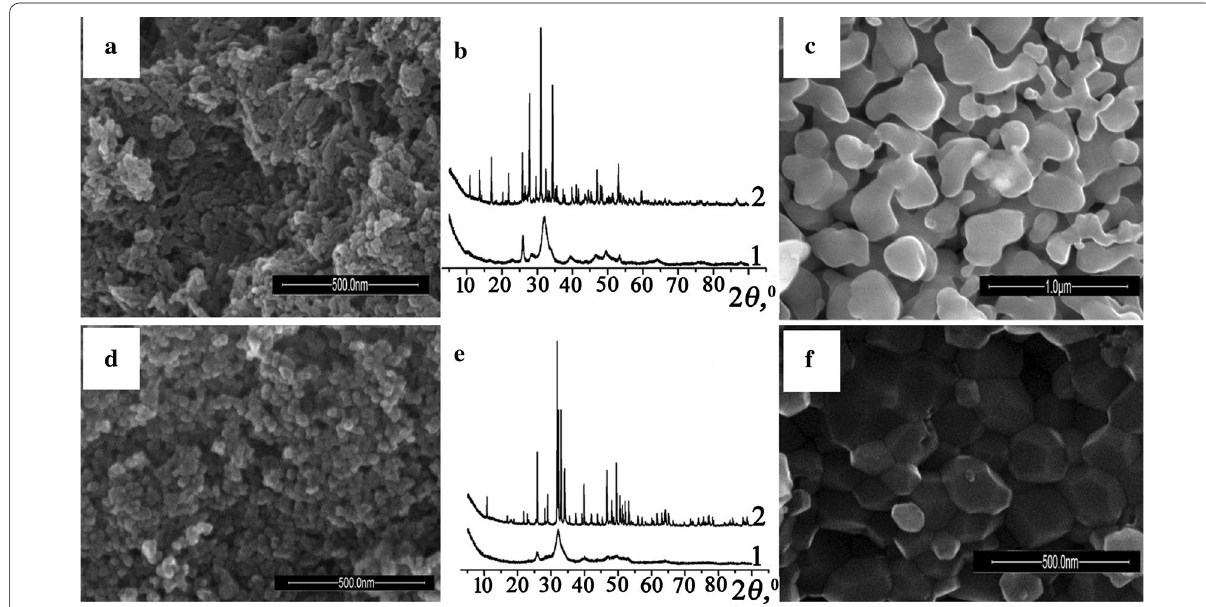
Fig. 1 Example of SEM images ( a , c , d , f ) and XRD patterns ( b and e ) for calcium phosphates (samples III ( a – c ) and IV ( d – f )) dried at 80 °C ( a , d , curves 1) and heated to 700 °C ( c , f , curves